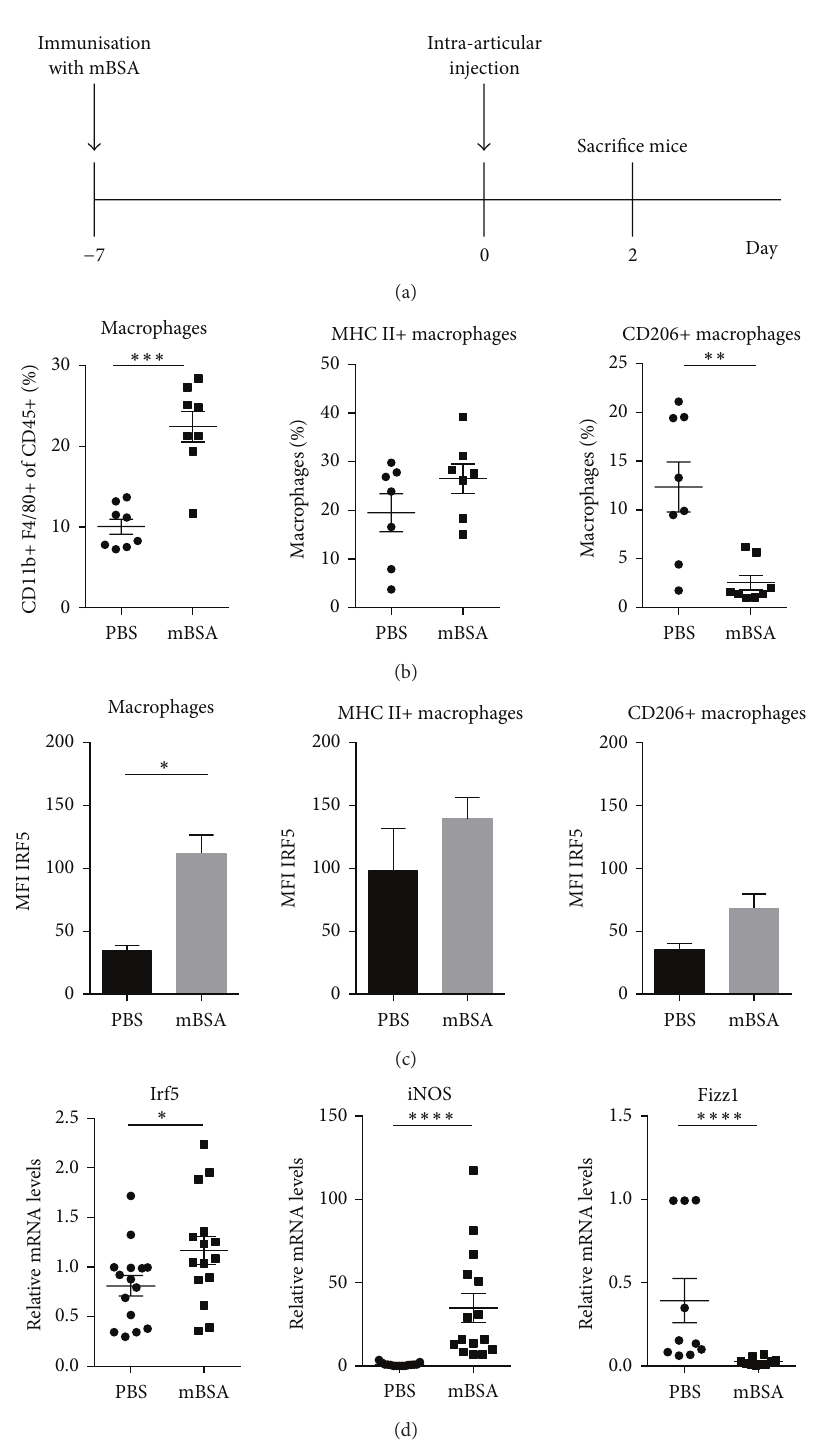
Figure 3: Macrophage populations and IRF5 expression at the site of inflammation in a mouse model of arthritis. Mice were immunised with mBSA in complete Freud’s adjuvant prior to intra-articular injection of mBSA or PBS. Knees were collected at day two of disease. (a) Schematic of the experimental set-up for antigen-induced arthritis. (b) Samples from three independent experiments were stained for flow cytometry with antibodies against CD45, CD11b, F4/80, CD206, and MHC II. (c) IRF5 FACS staining was quantified calculating the mean fluorescence intensity in knees of three wild type mice. (d) Total RNA was isolated from knees of three independent experiments and analysed by real-time PCR for expression of Irf5, iNOS, and Fizz1. Statistical analysis was performed throughout by one-tailed Mann-Whitney 𝑈 test. ∗ 𝑃 ≤ 0.05 ; ∗∗ 𝑃 ≤ 0.01 ; ∗∗∗ 𝑃 ≤ 0.001 ; ∗∗∗∗ 𝑃 ≤ 0.0001